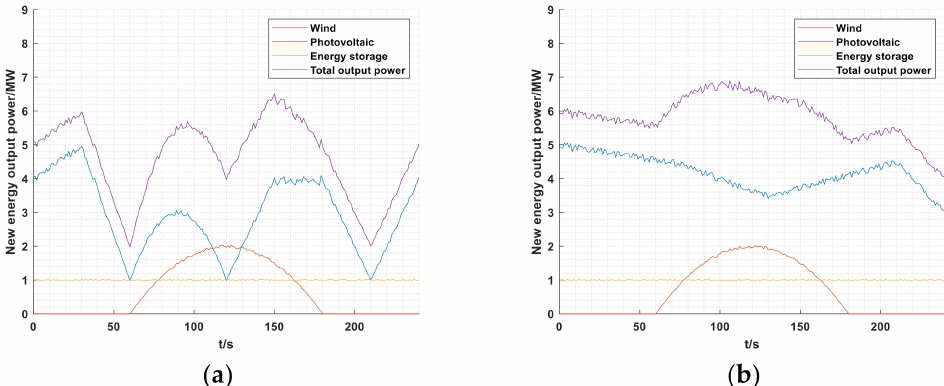
Figure 13. Wind-photovoltaic-energy storage output curve. ( a ) When the wind speed changes rapidly; ( b ) When the wind speed changes relatively gently.